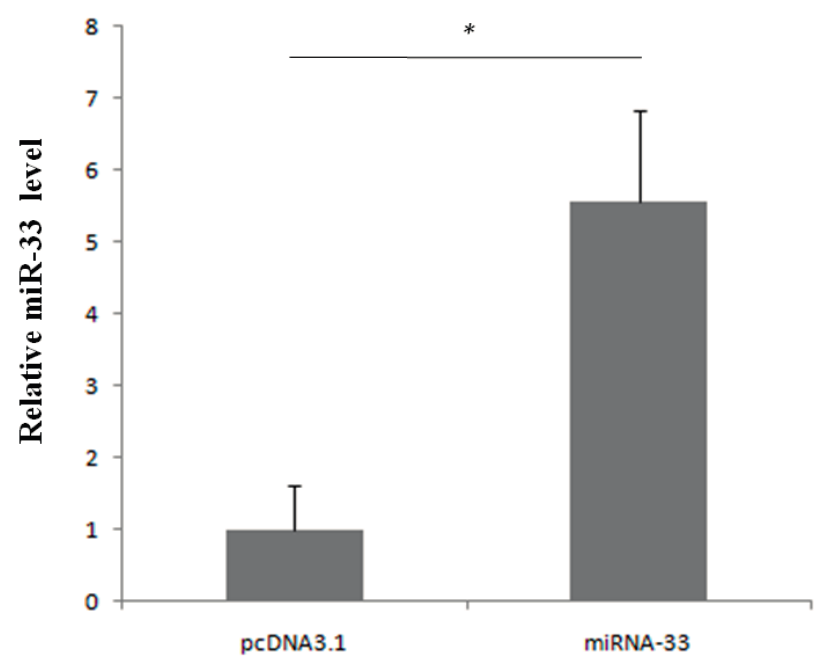
Figure 4. miR-33 expression in the CHO cells. * represents p <